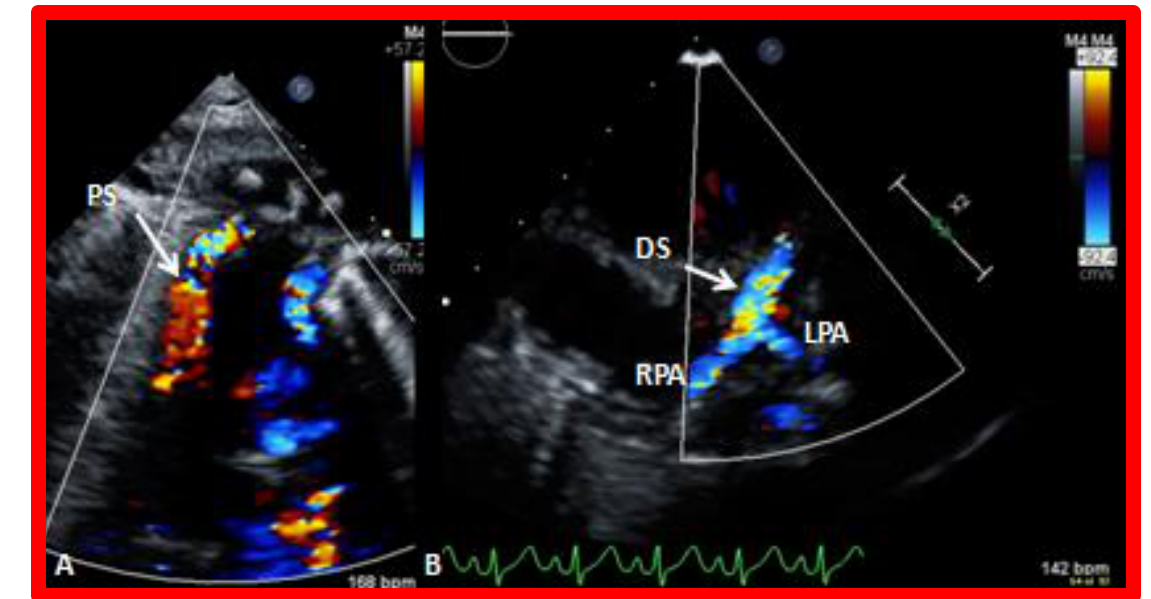
Figure 9. ( A ) . Selected cine-angiographic frame showing modified Blalock-Taussig (BT) shunt con- necting left subclavian artery (LSA) with the pulmonary artery (PA) with a Gore-Tex grafts (GG) [30]. This cine frame shows wide-open BT shunt and excellent opacification of PA. ( B ). Selected cine frame form PA cine-angiogram in straight lateral projection demonstrating narrowed section of the PA produced by pulmonary artery band (PB) shown by arrow in ( B ) in an infant who had the PB [37]. C, catheter; LPA, left pulmonary artery; NG, nasogastric tube; PG, pigtail catheter; RPA, right pulmonary artery. Modified from [7].